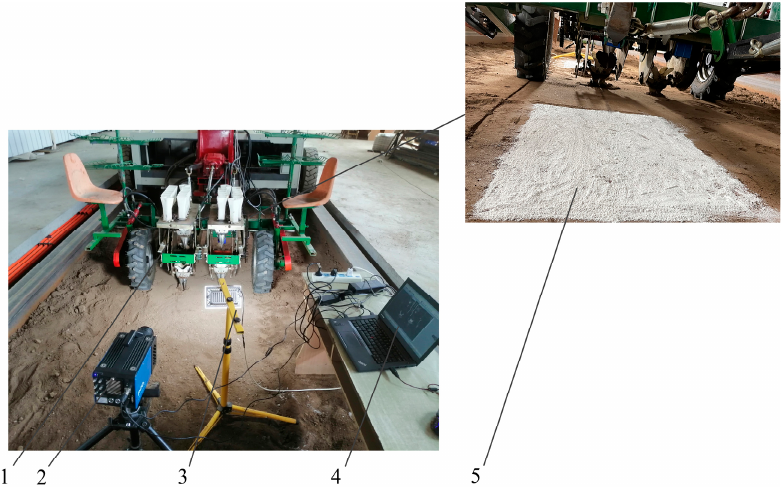
Figure 3. High ‐ speed photography system construction. 1. Hanging ‐ cup transplanter; 2. high ‐ speed Figure 3. High-speed photography system construction. 1. Hanging-cup transplanter; 2. high-speed camera; 3. LED fill light; 4. laptop computer; and 5. marker block. camera; 3. LED fill light; 4. laptop computer; and 5. marker